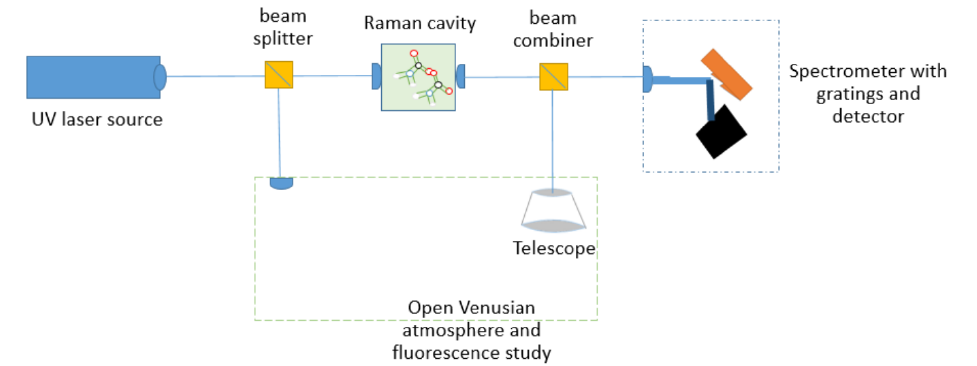
Figure 7. Schematic of the instrument baseline. The laser is obliquely placed near the receiving tele-